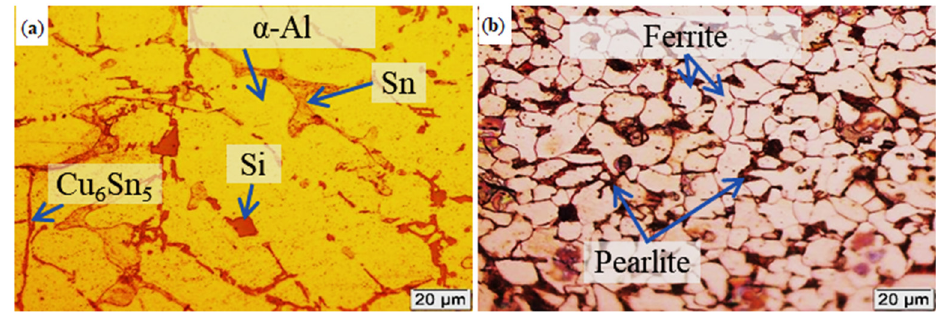
Figure 2. Microstructures of ( a ) Al-based bearing alloy and ( b ) steel substrate used for preparing bimetallic materials.